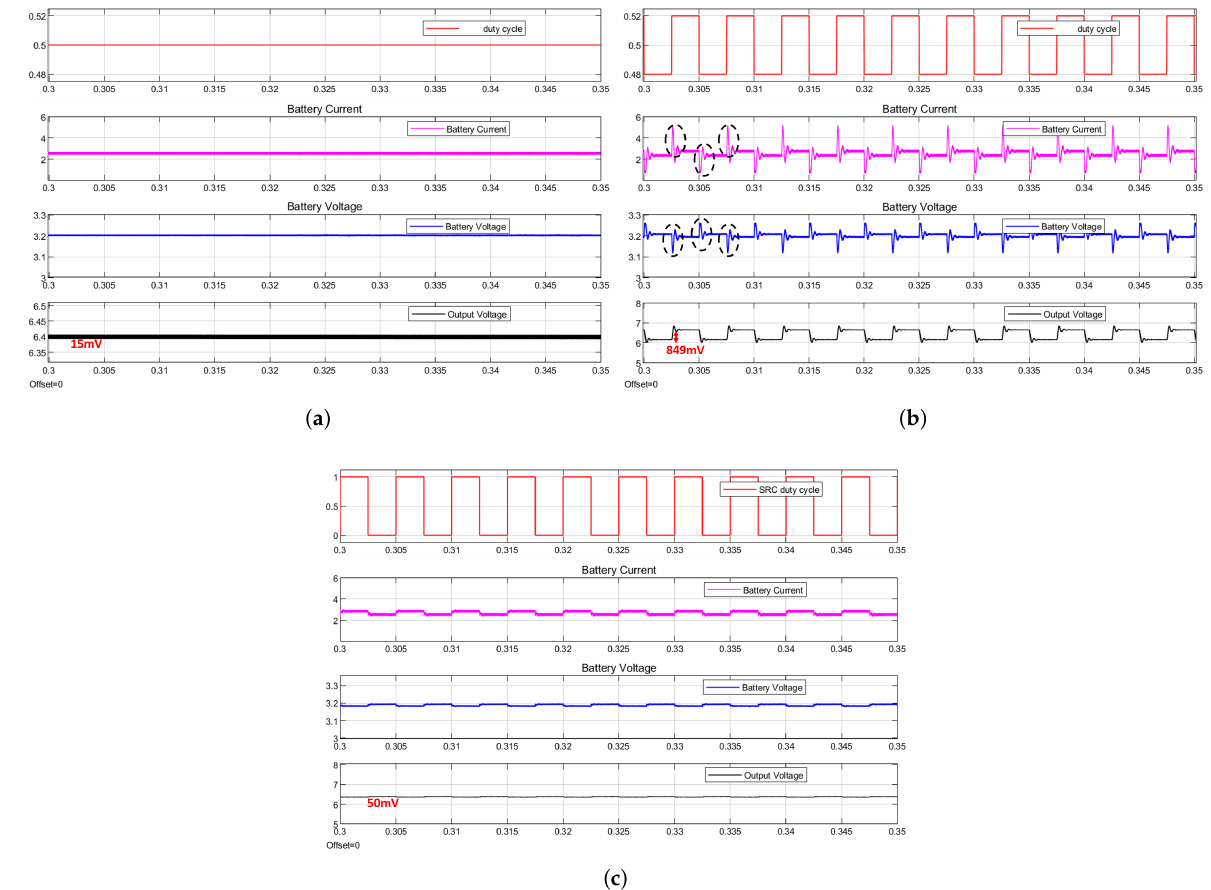
Figure 4. ( a ) Waveforms of the converter under normal power delivery mode (no perturbation). ( b ) Waveforms of the converter under impedance measurement mode with duty cycle perturbation. ( c ) Waveforms of the converter under impedance measurement mode with the proposed SRC perturbation